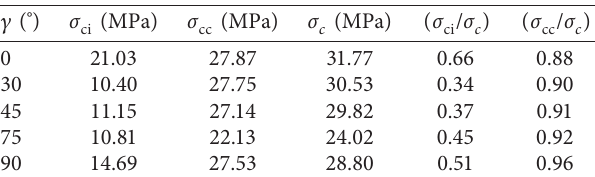
Table 6: The crack initiation and coalescence stress ( c ) for different angles between main and minor flaws ( c ).